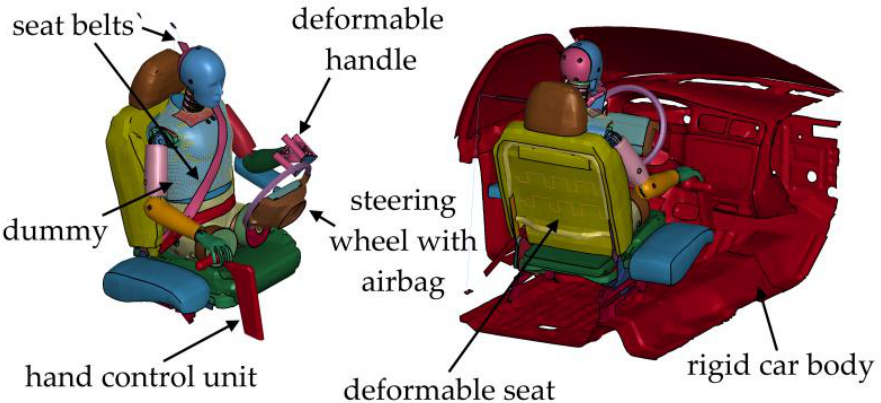
Figure 2. Numerical model used in simulations.